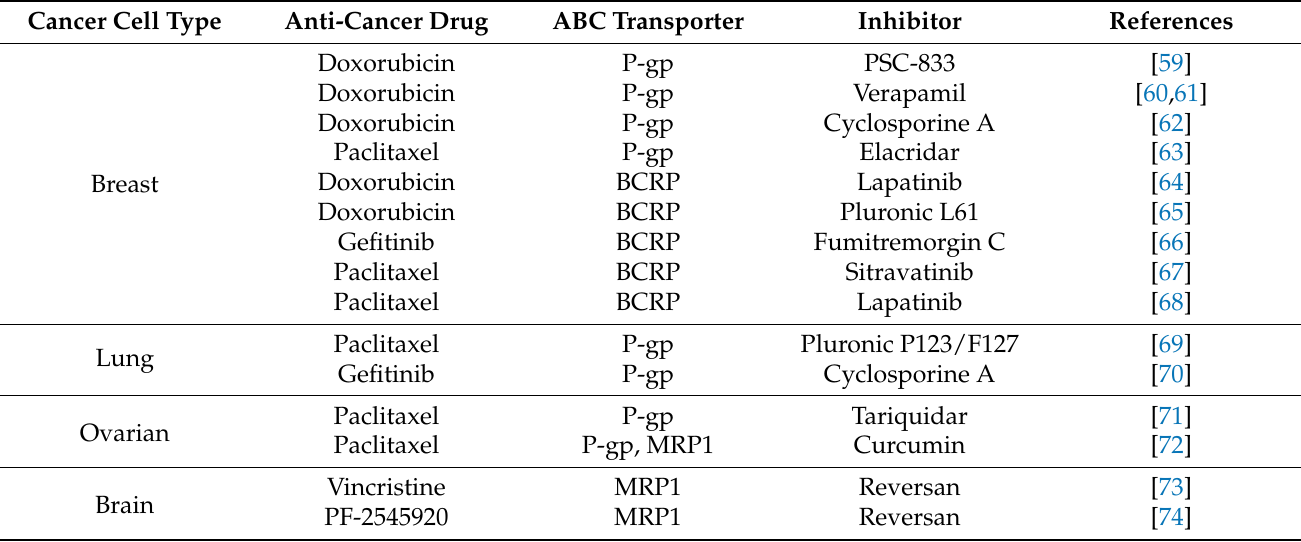
Table 1. Co-delivery of ABC transporter inhibitors and anti-cancer drugs. Cancer Cell